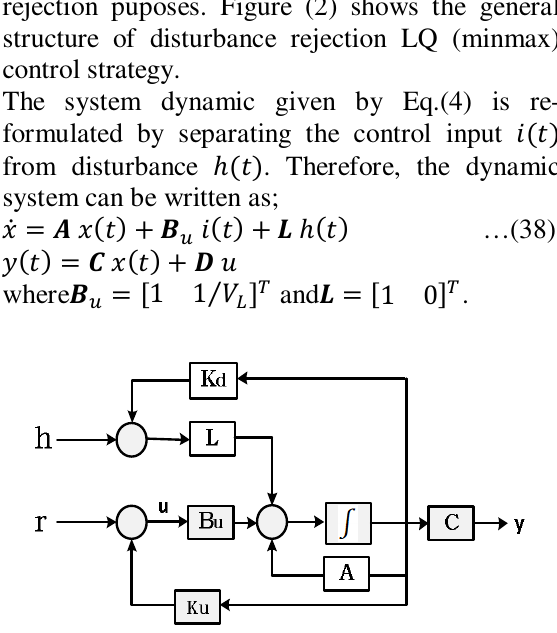
Fig. 2.General structure of Minimax Control [15].